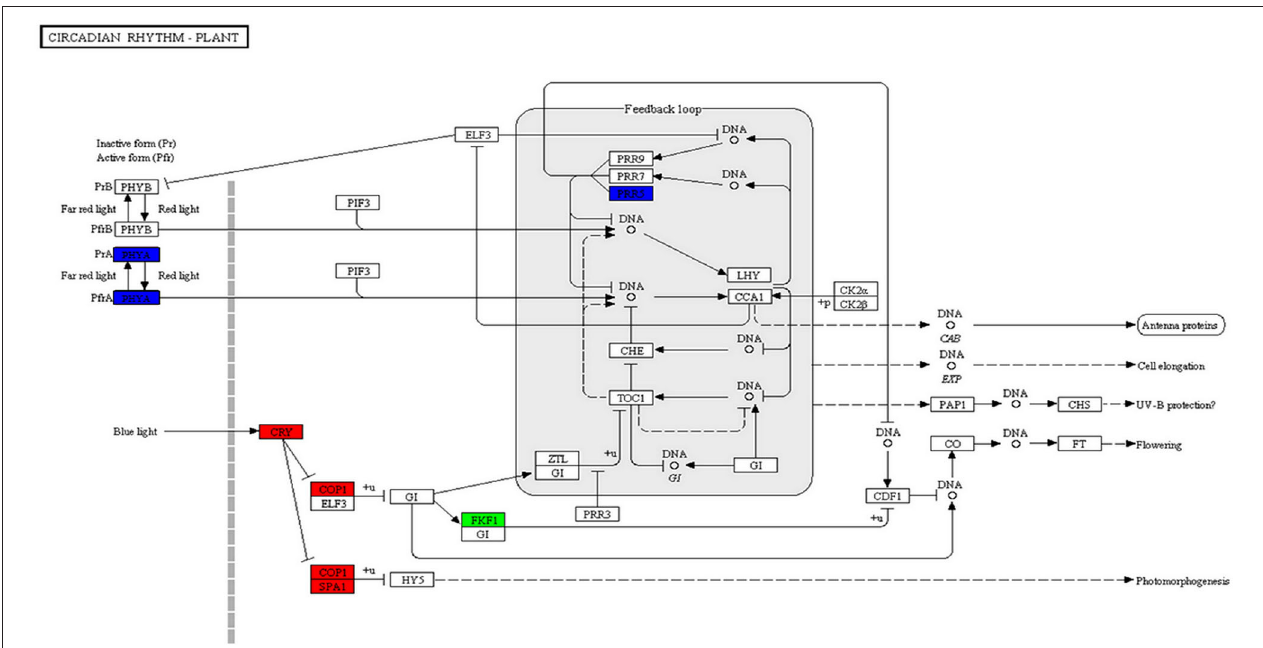
FIGURE 6 | The plant circadian rhythm of the top 20 KEGG pathways in potato. The nodes are marked in red background color indicating the DEGs is up-regulated expression, the nodes are marked in green background color indicating the DEGs is down-regulated expression, and the nodes are marked in blue background color indicating the DEGs is up-/ down-regulated